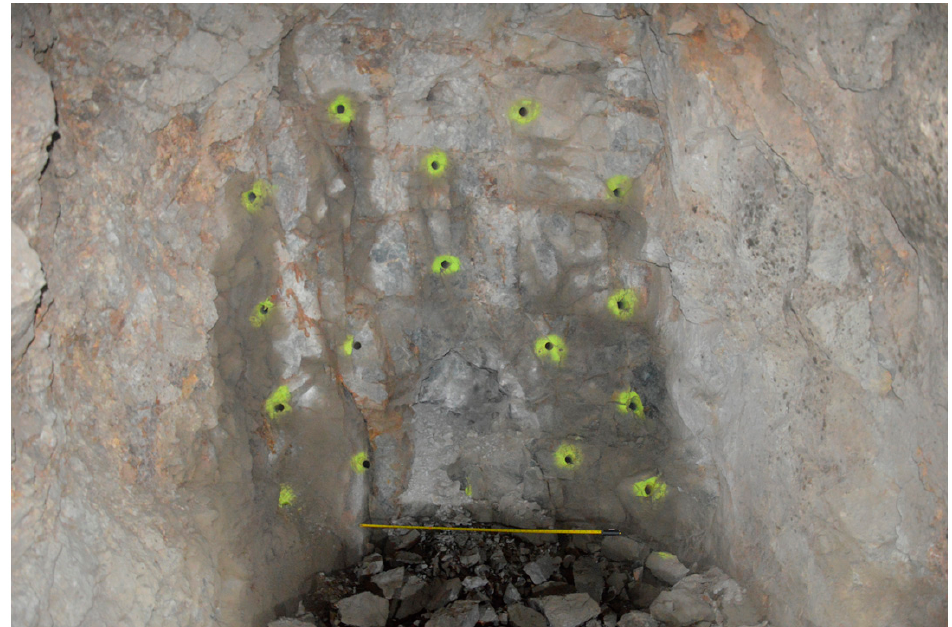
Figure A5. Cavity after detonation of hole with sequence number 4.